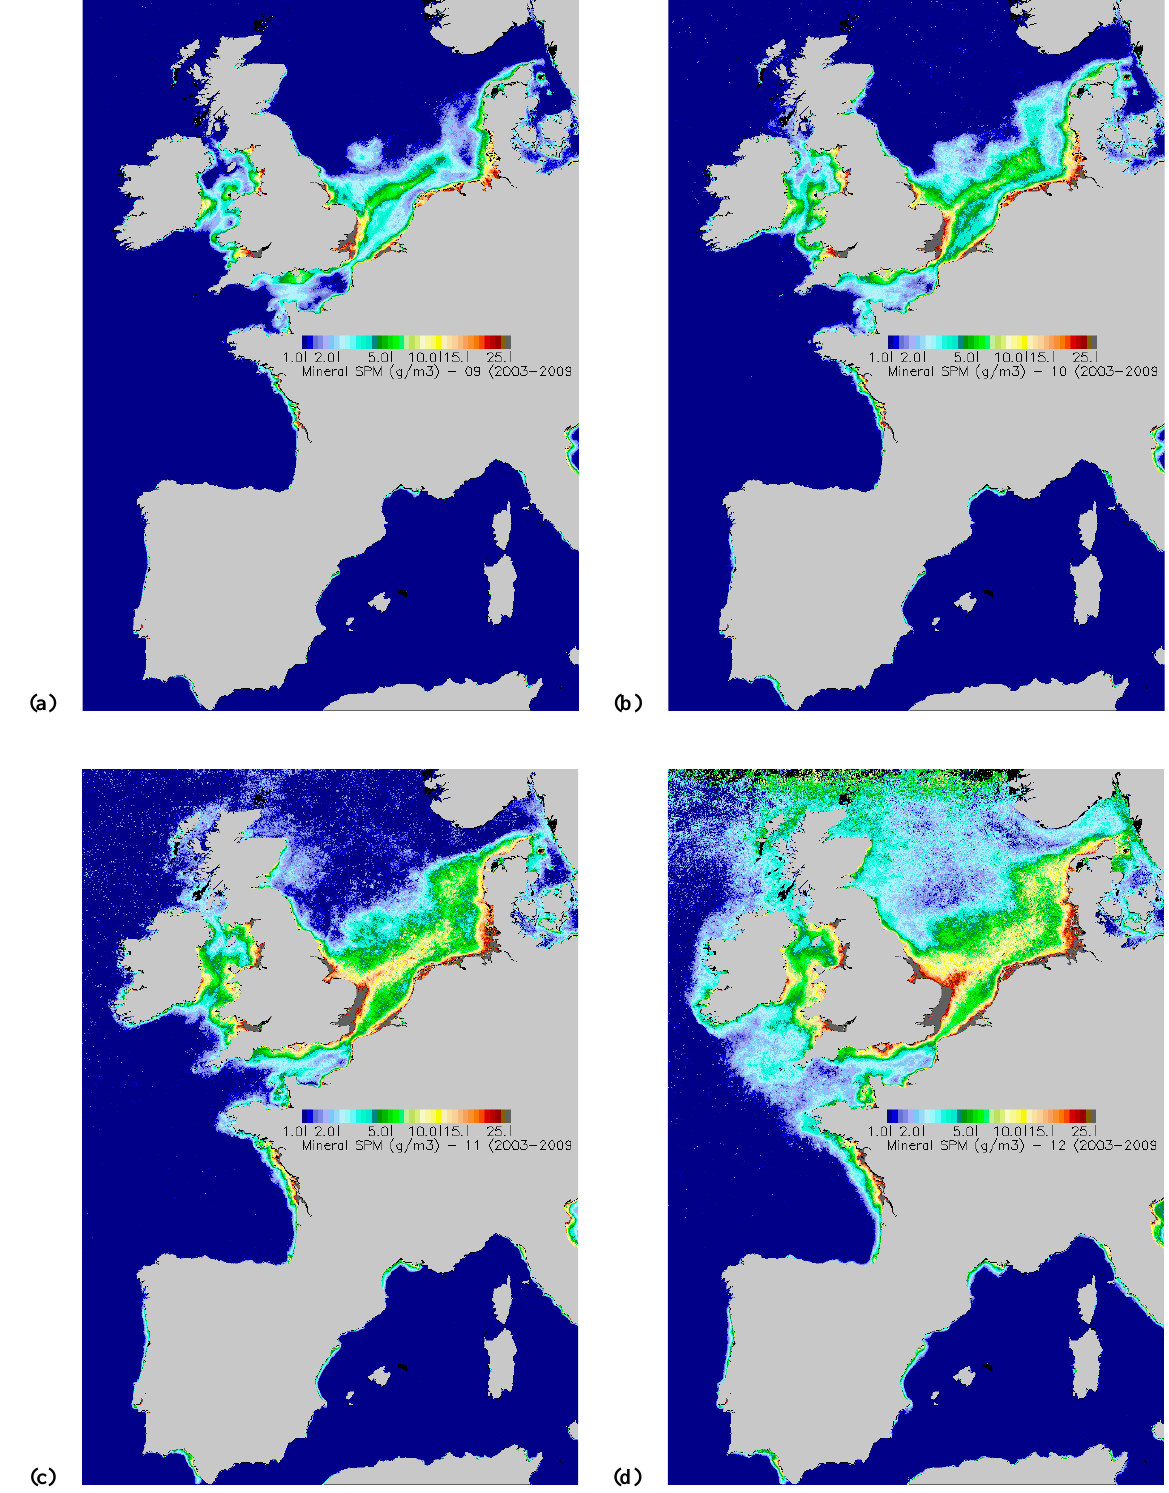
Fig. B3. Monthly non-algal SPM in September (a) , October (b) , November (c) and December (d)